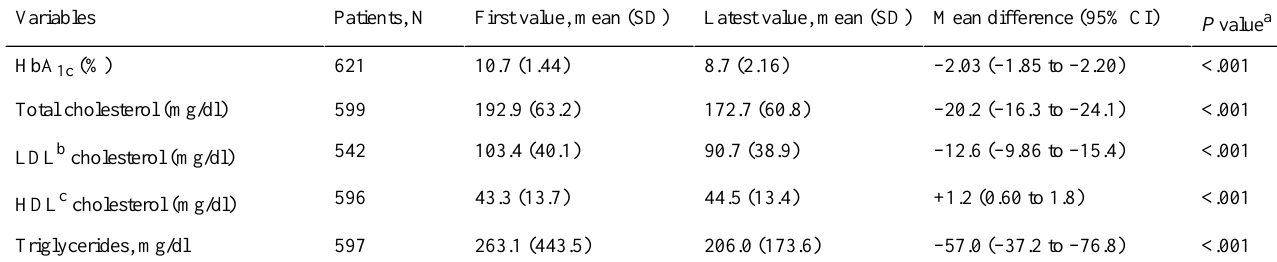
Table 3. Changes in glycated hemoglobin (HbA 1c ) and